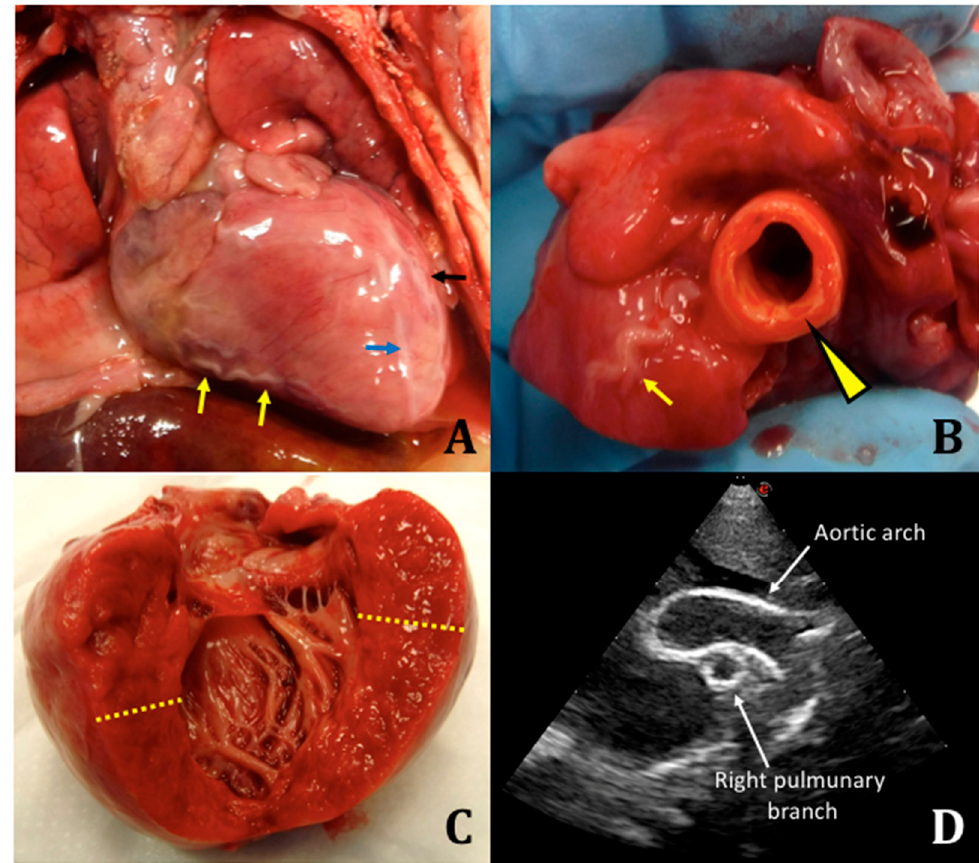
Figure 1. ( A ) Anterior surface of the heart at autopsy. Coronary arteries are thickened, whitish, and sometimes serpiginous. Yellow arrows: right marginal branch of the right coronary artery; blue arrow: left anterior descending artery; black arrow: left marginal artery. ( B ) Detail of the ascending tract of the aorta; the wall appears thickened (arrowhead). On its side, it can be observed the first tract of the right coronary artery thickened, whitish, and serpiginous (arrow). ( C ) Left heart ventricle. The yellow lines highlight the marked hypertrophy of the wall. ( D ) Aortic arch and right pulmonary artery on a postnatal cardiac